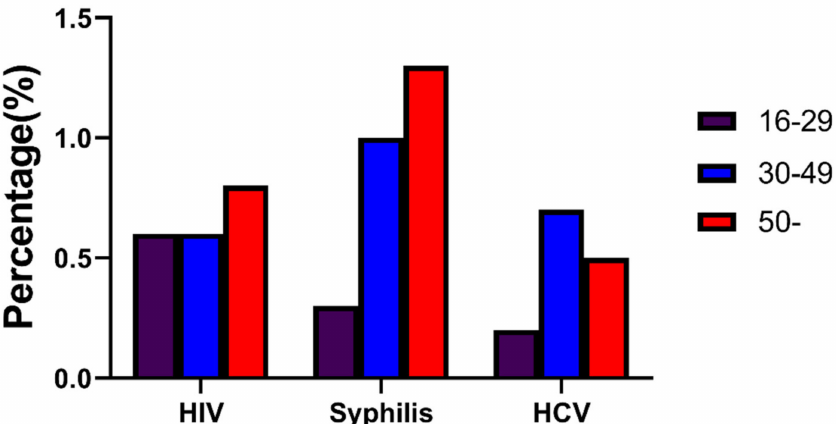
Figure 2. Overall prevalence of HIV, syphilis, and HCV for MMWs of three age groups in Chongqing from 2010 to